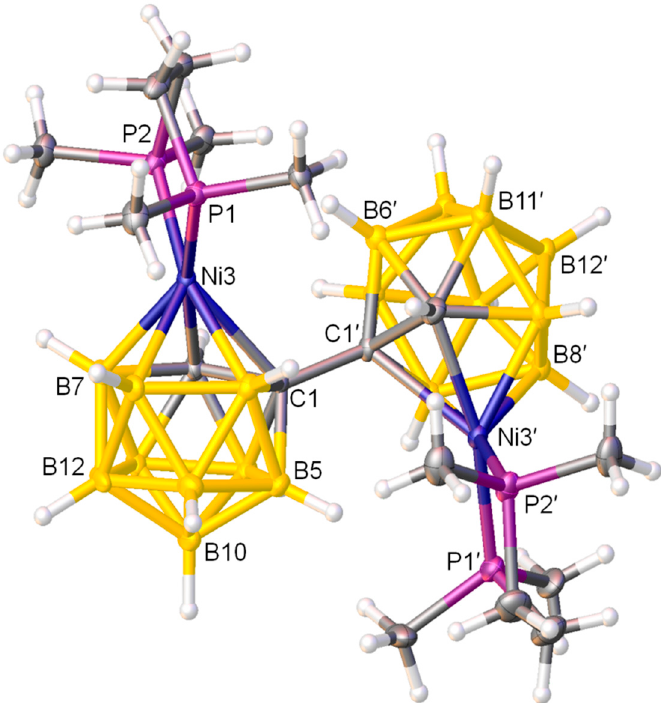
Figure 2. Molecular structure of meso -[1-(1 ′ -3 ′ -(dmpe)-3 ′ ,1 ′ ,2 ′ - closo -NiC 2 B 9 H 10 )-3-(dmpe)-3,1,2- closo - NiC 2 B 9 H 10 ] ( 2 ).